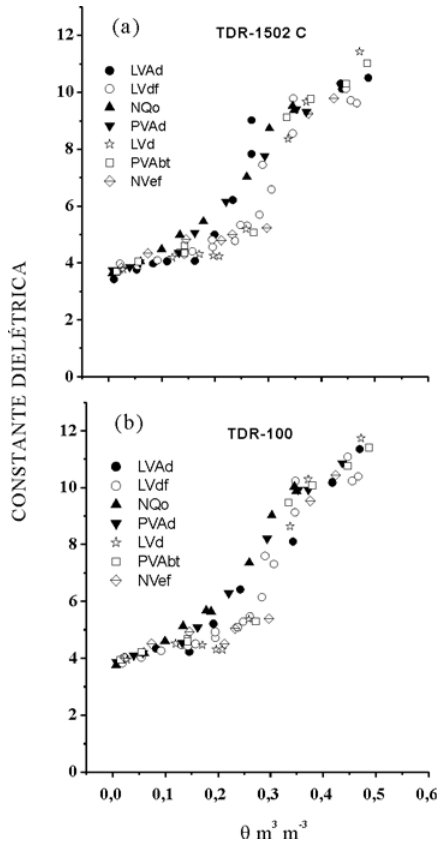
Figura 3. Constantes dielétricas medidas para os sete solos estudados considerando a umidade com a sonda espiral de TDR para o TDR-1502C (a) e o TDR-100 (b), determinadas em amostras de solo deformadas, em